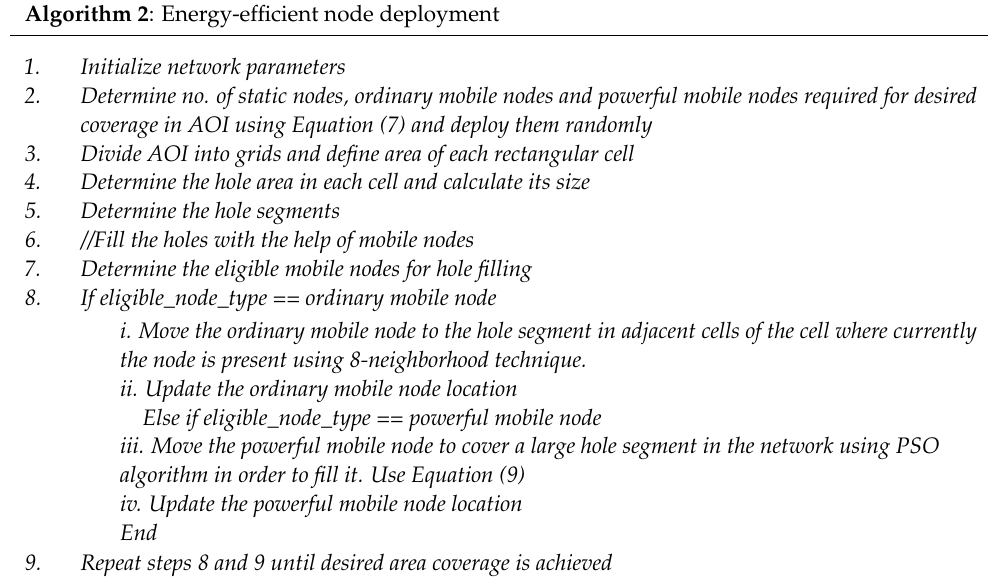
Algorithm 2 : Energy-efficient node